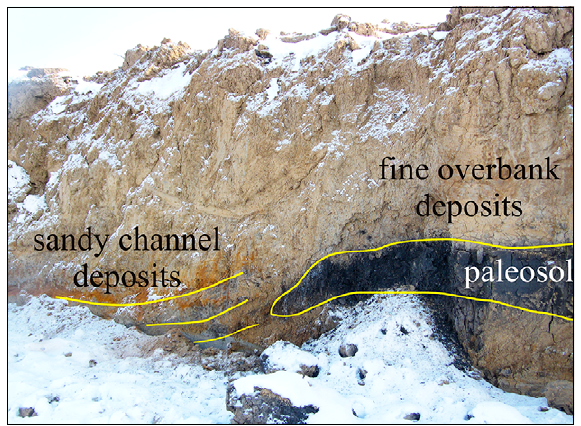
Figure 4. During the activity of the crevasse the overbank fluvial processes were limited, thus a thick paleosol